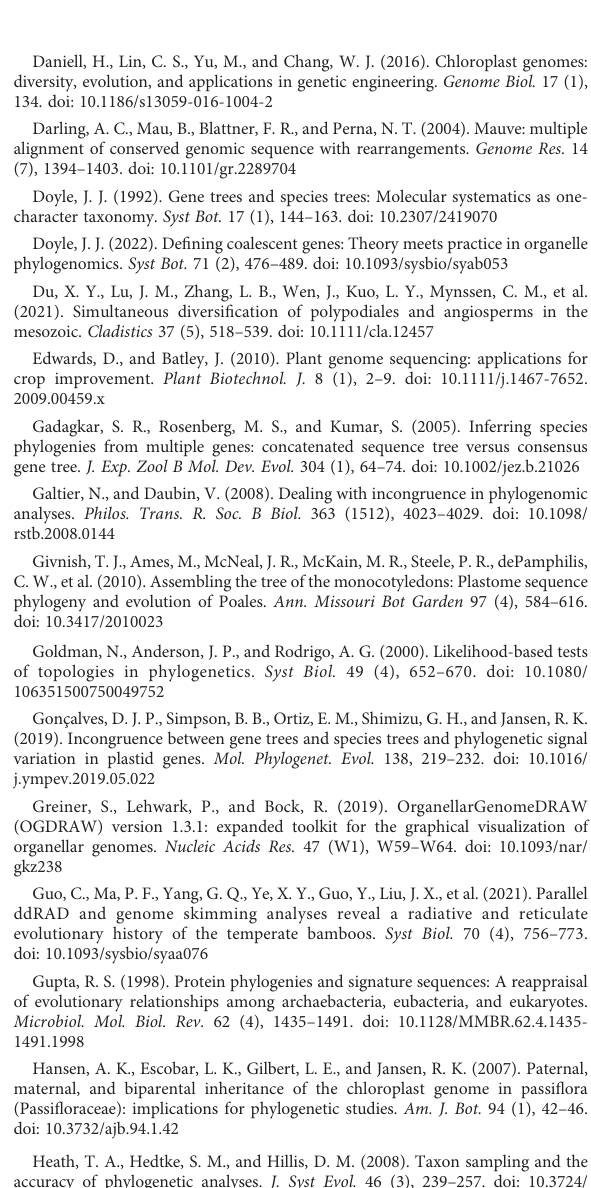
SUPPLEMENTARY FIGURE 1 Density plots of long-branch score, slope values and R 2 values for 166 loci generated using R . SUPPLEMENTARY FIGURE 2 Tree topology and branch length indicated maximum-likelihood (ML) analysis based on amino acid matrix, and branches of each family are designated in different colors. SUPPLEMENTARY FIGURE 3 Linearized map comparison of the plastid genomes of Dennstaedtioideae (clades 1-4). Syntenic blocks are shown in different